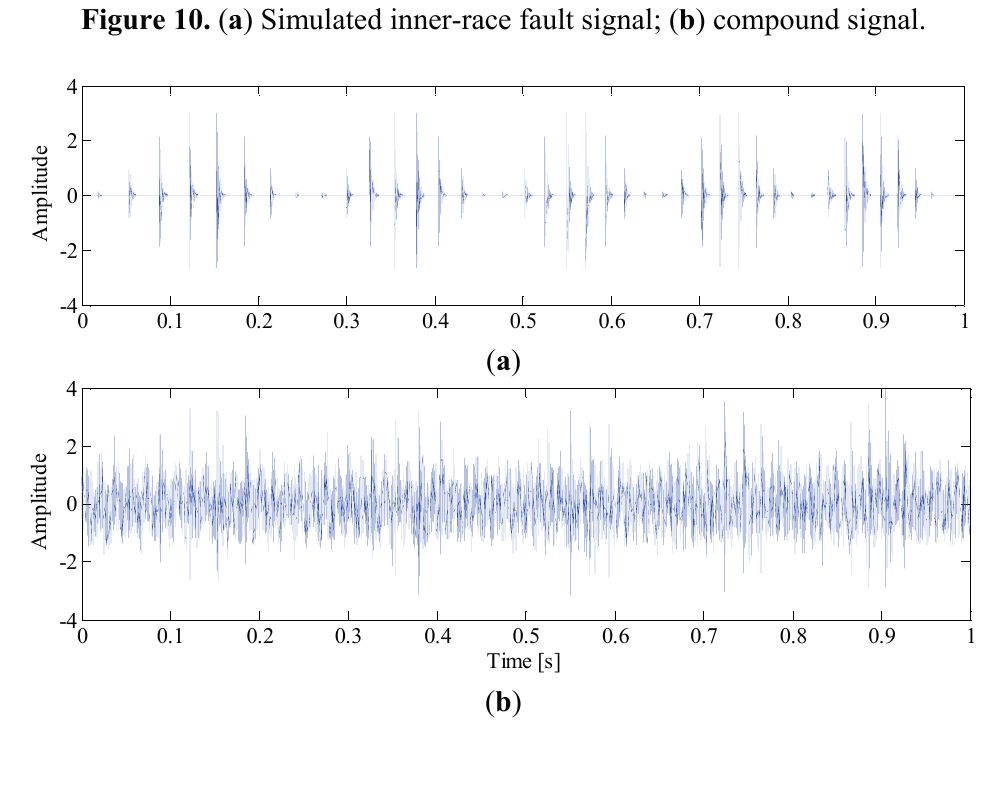
Figure 10. ( a ) Simulated inner-race fault signal; ( b ) compound